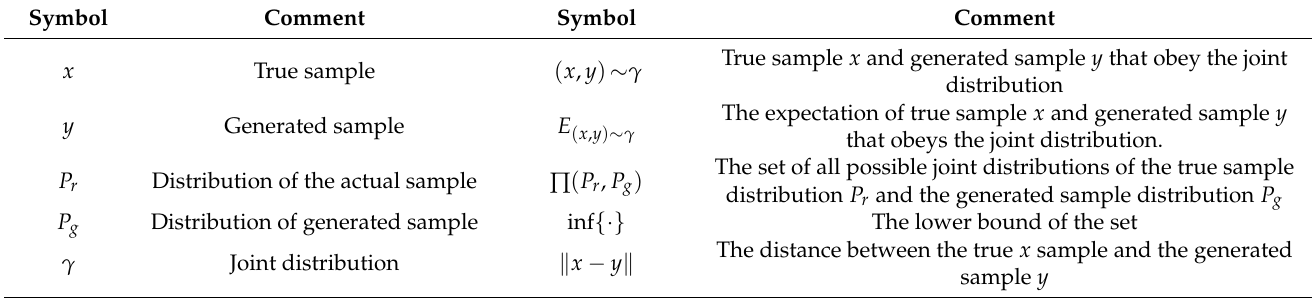
Table 2. Parameters in the mechanical model.